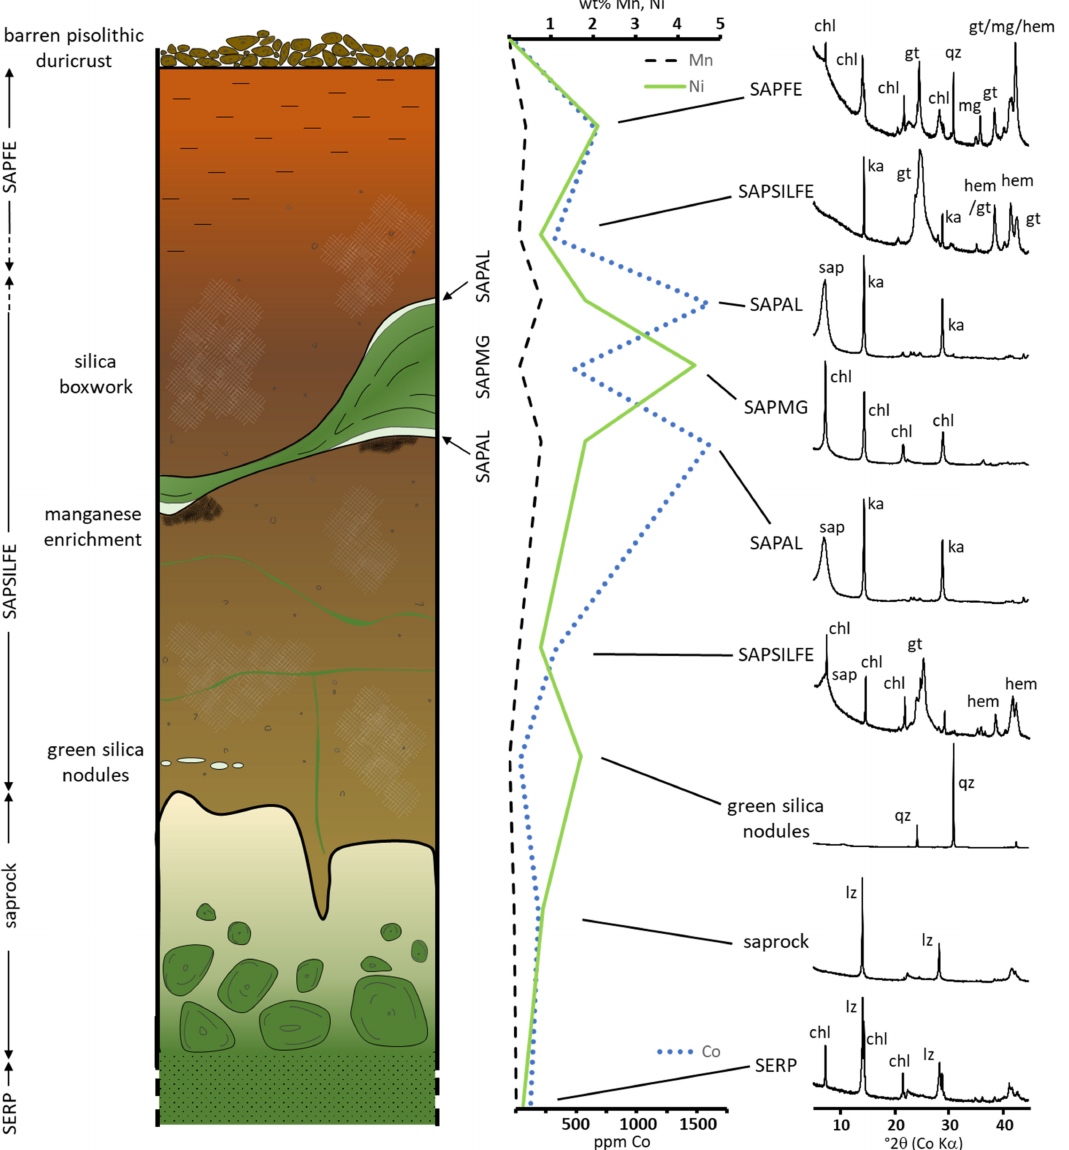
Figure 7. Representative XRD patterns from the different lithological units of the Piau í deposit ( right ). The XRD patterns are plotted with a stylized schematic profile for the Piau í laterite ( left ) and the associated average Co, Ni and Mn contents from Table 4 ( centre ). NB this is not a true representation of the profile of the deposit; the Piau í laterite is vertically and horizontally variable and the schematic shown here condenses the major features into a single representative profile. XRD patterns are from samples (top to bottom): SAPFE (F019), SAPSILFE (F043), SAPAL (F014), SAPMG (F006), SAPAL (F015), SAPSILFE (F030), green silica nodules (F008), saprock (F017), serpentinite (F046). chl = chlorite, lz = lizardite, ka = kaolinite, qz = quartz, sap = saponite, gt = goethite, hem = hematite, mg =